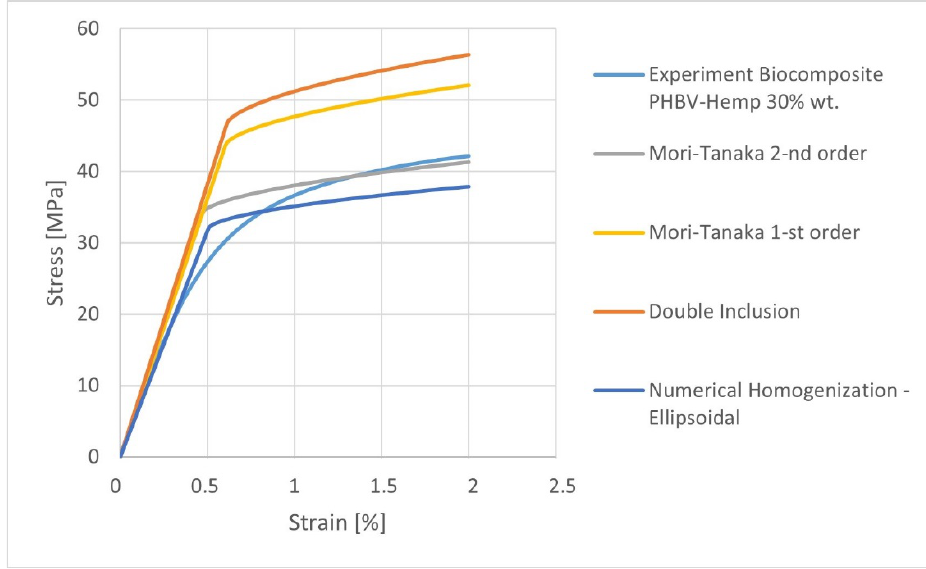
Figure 11. The stress-strain characteristics for K30 biocomposites calculated using analytical and numerical homogenization methods.